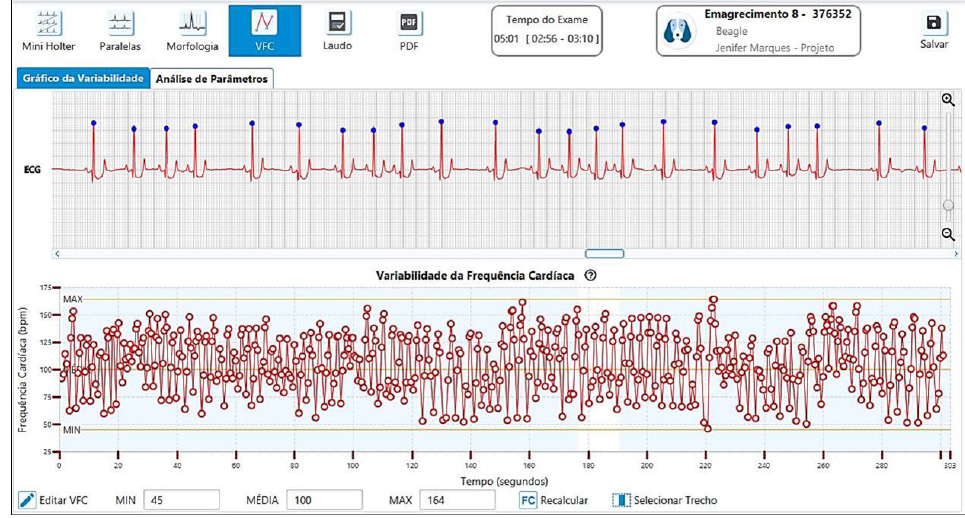
Figure 3. Heart rate variability (Variabilidade da frequência cardíaca) chart, showing R-R intervals, minimum, medium and maximum heart rate. Source: Service of Cardiology and Respiratory Diseases - UFRRJ.